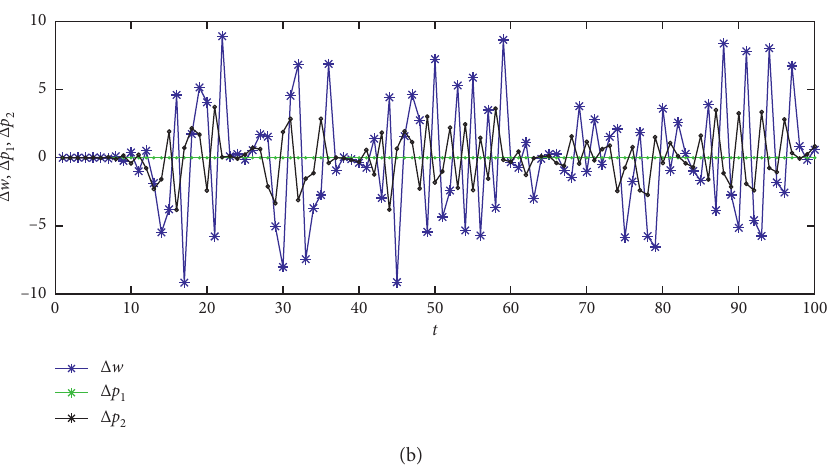
Figure 7: The sensitivity to initial value when ( w, p � 0 . 04 and α α 1